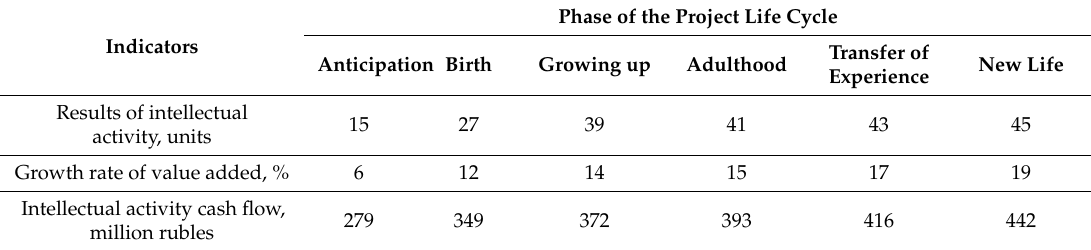
Table 8. Assessment of the project for the development of materials and technologies to improve expectancy and quality of life.